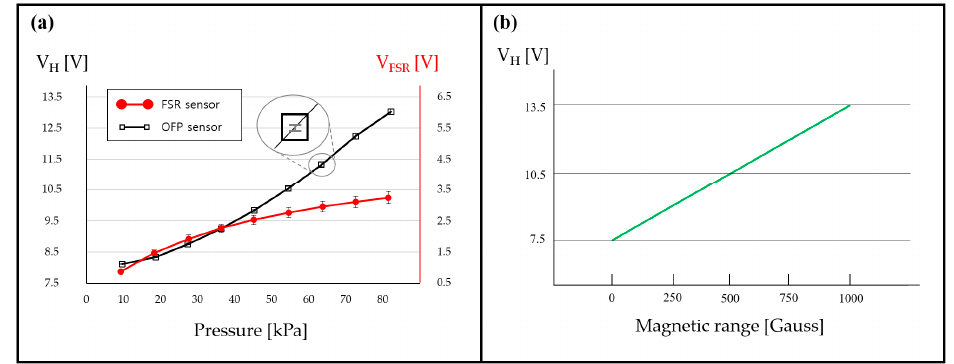
Figure 8. ( a ) Comparison of OFP and FSR402 sensors. The average relative standard deviation of the OFP sensor is less than 0.12, which is ten times less (better) than that of FSR402 (Measurement with Area 1). ( b ) Hall voltage vs. magnetic range [53,54].